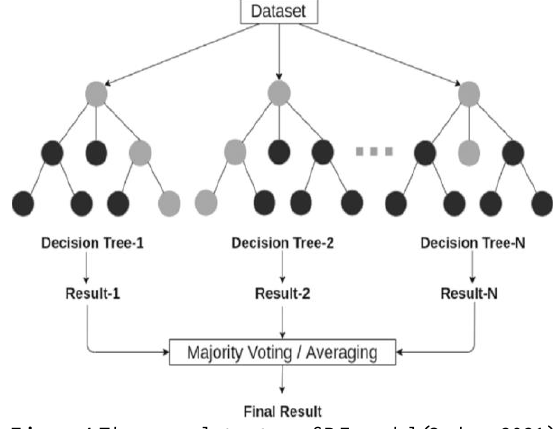
Figure 4 .The general structure of RF model (Sarker, 2021)